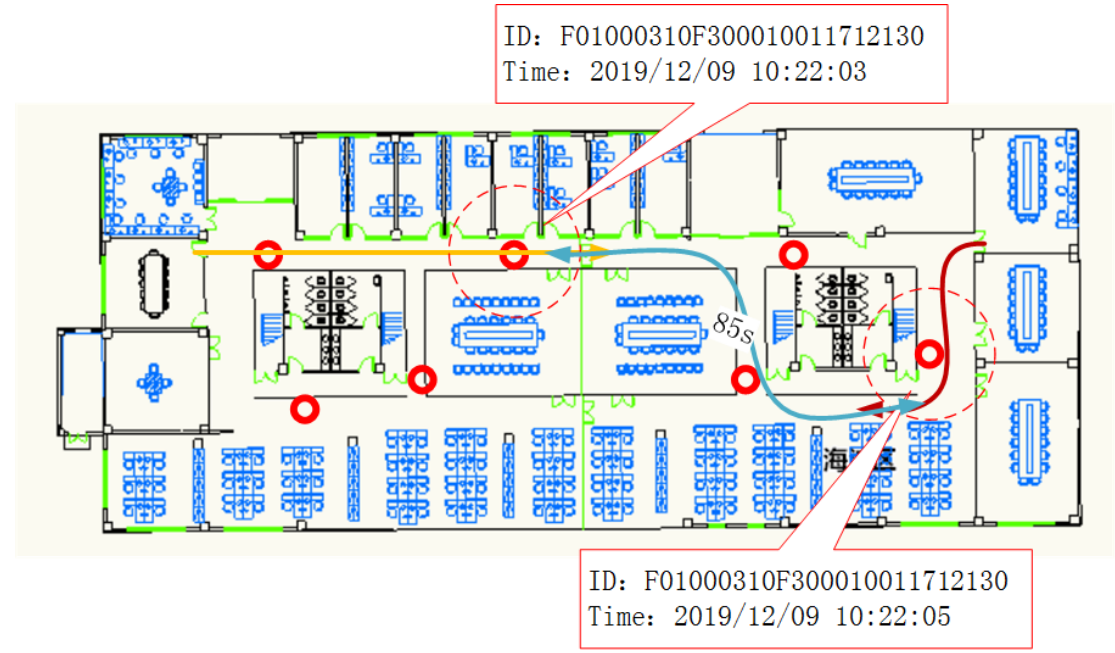
Figure 3. Abnormal detection.